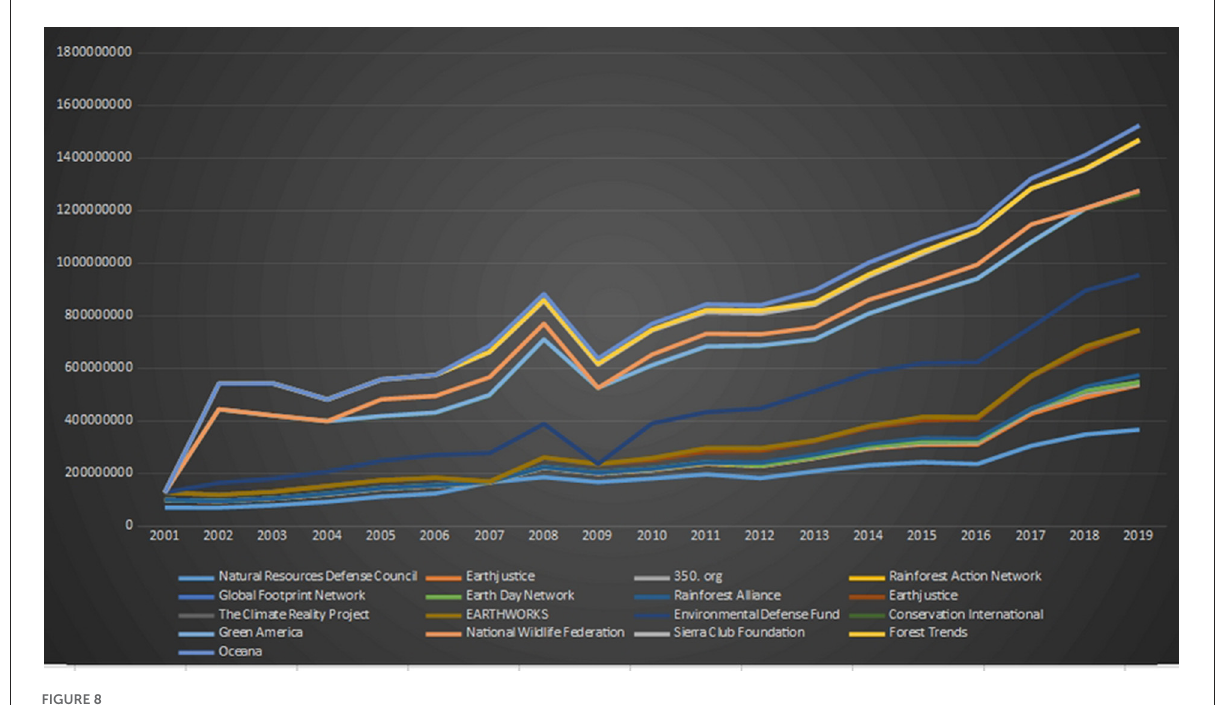
FIGURE8 Growth chart of 17 important environmental NGOs